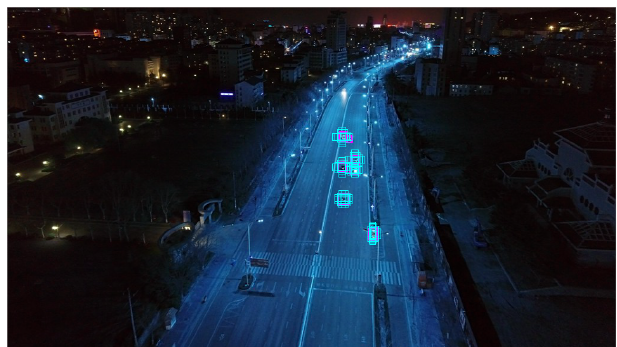
Figure 7. Example of Multi-scale Sampling